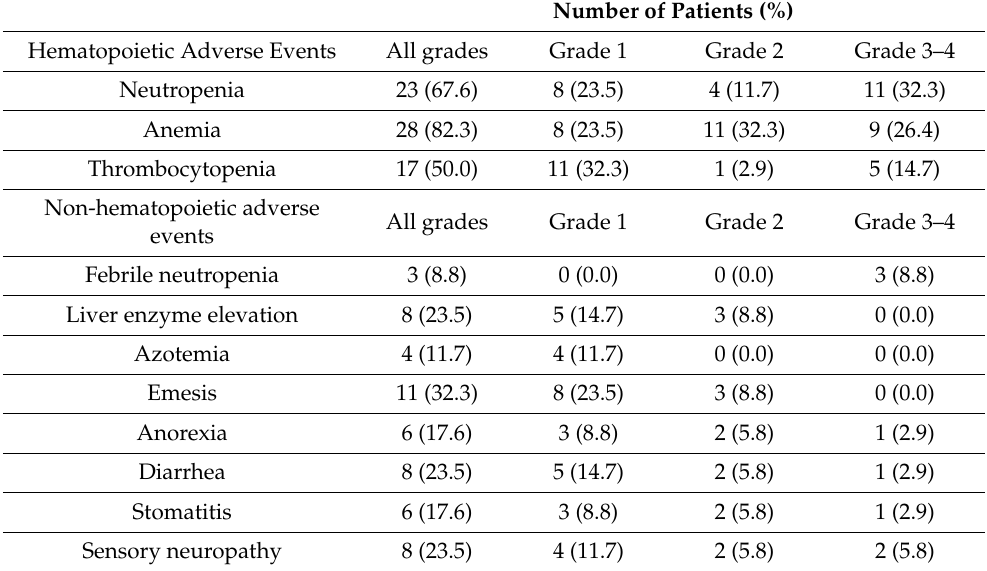
Table 2. Adverse events of mFLOFIRINOX